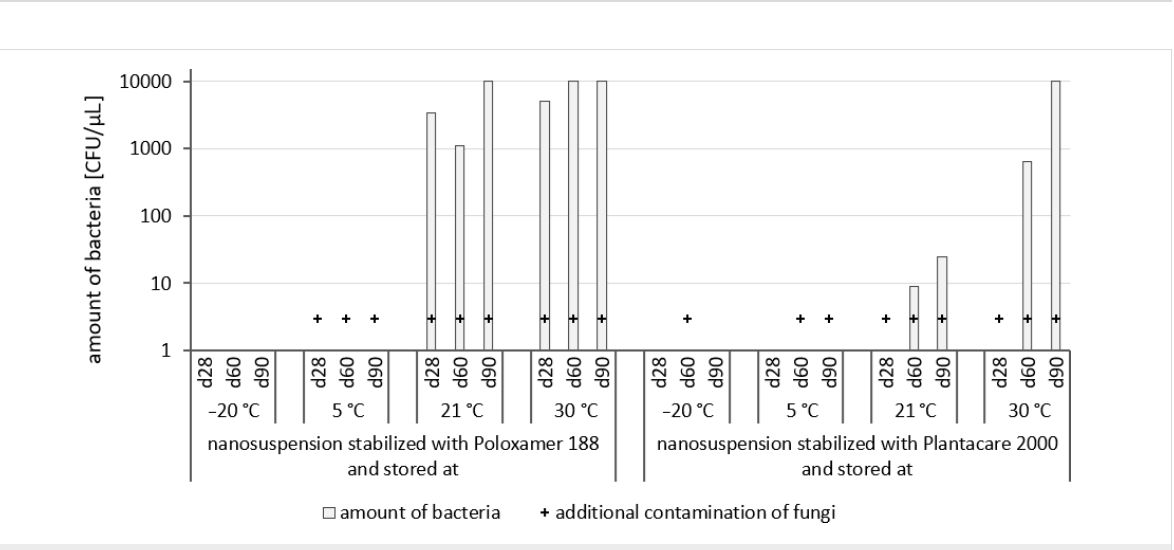
Figure 10: Determination of microbial activity (CFU) during three months of